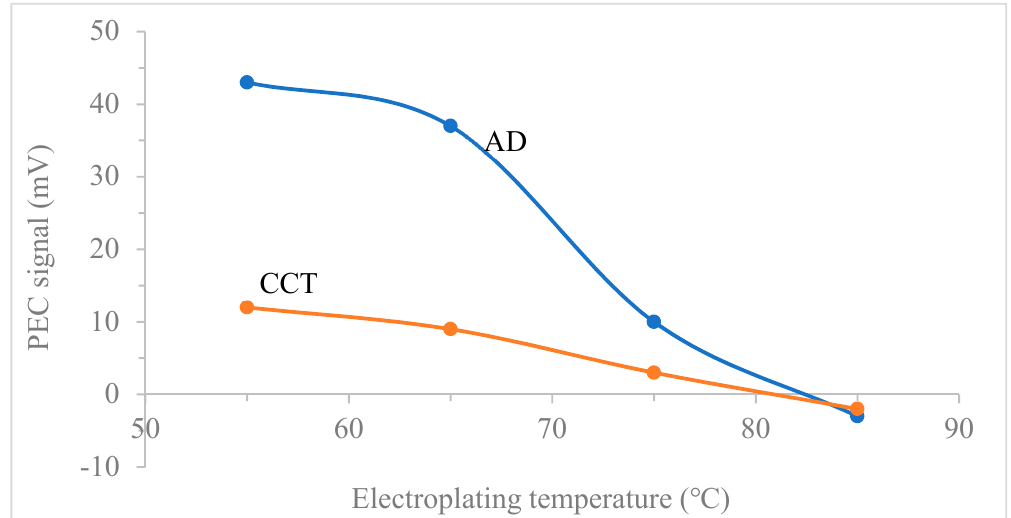
Figure 10. A plot of PEC signal of CdTe electroplated from electrolytes at different deposition temperatures against electroplating temperature under both AD and CCT conditions.